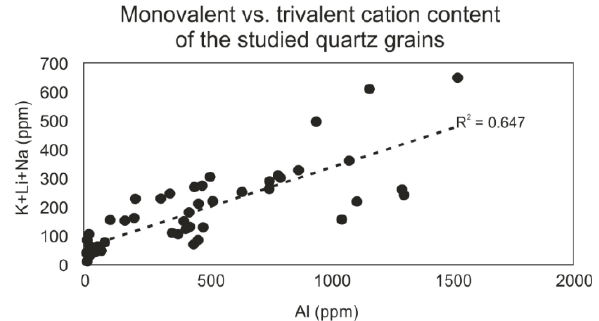
Figure 7. Monovalent (K + Li + Na) vs. trivalent (Al) cation content of the studied quartz grains from Boccassuolo and Campegli.